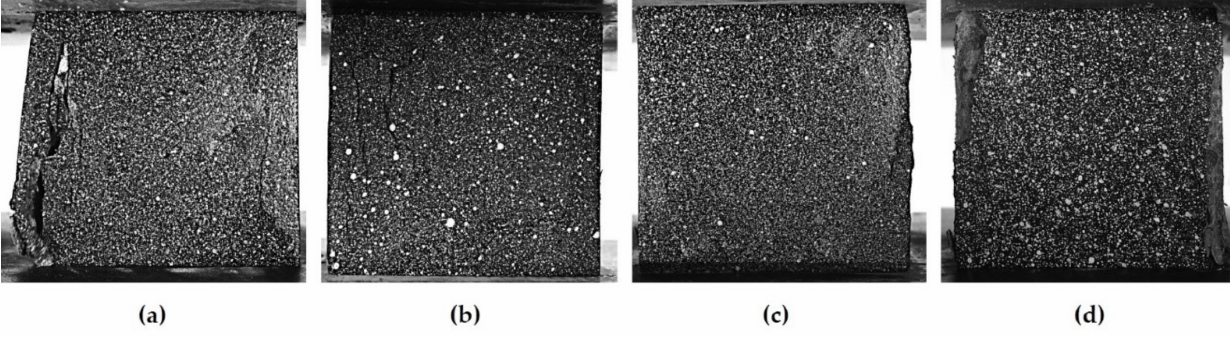
Figure 8. Fractured concrete cubes. ( a ) OPC-F, ( b ) OPC-S, ( c ) CAC-F, and ( d )